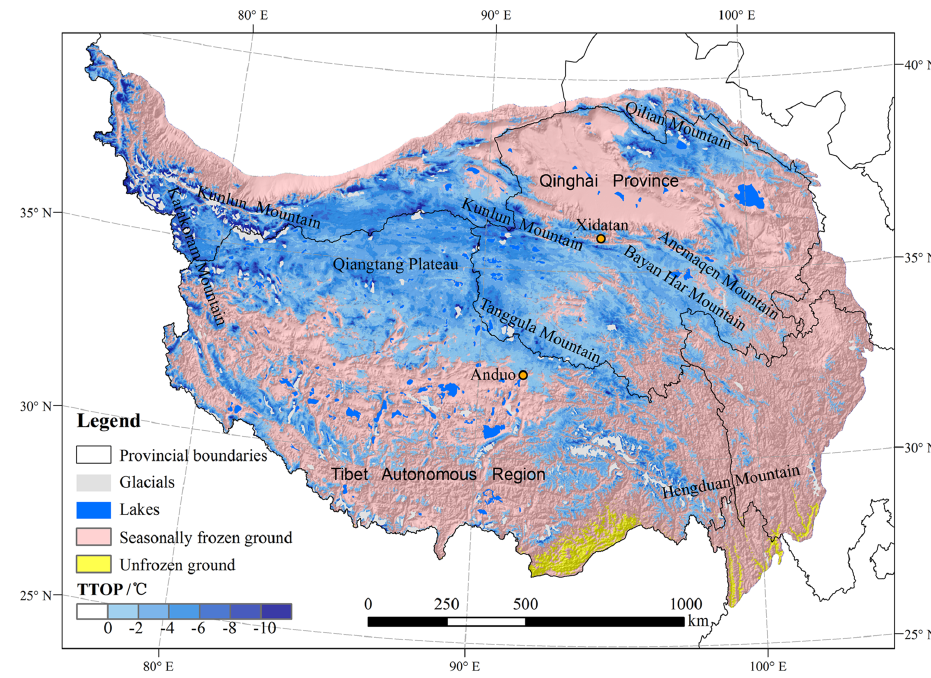
Figure 3. Spatial distribution of permafrost with the derived TTOP on the Tibetan Plateau.